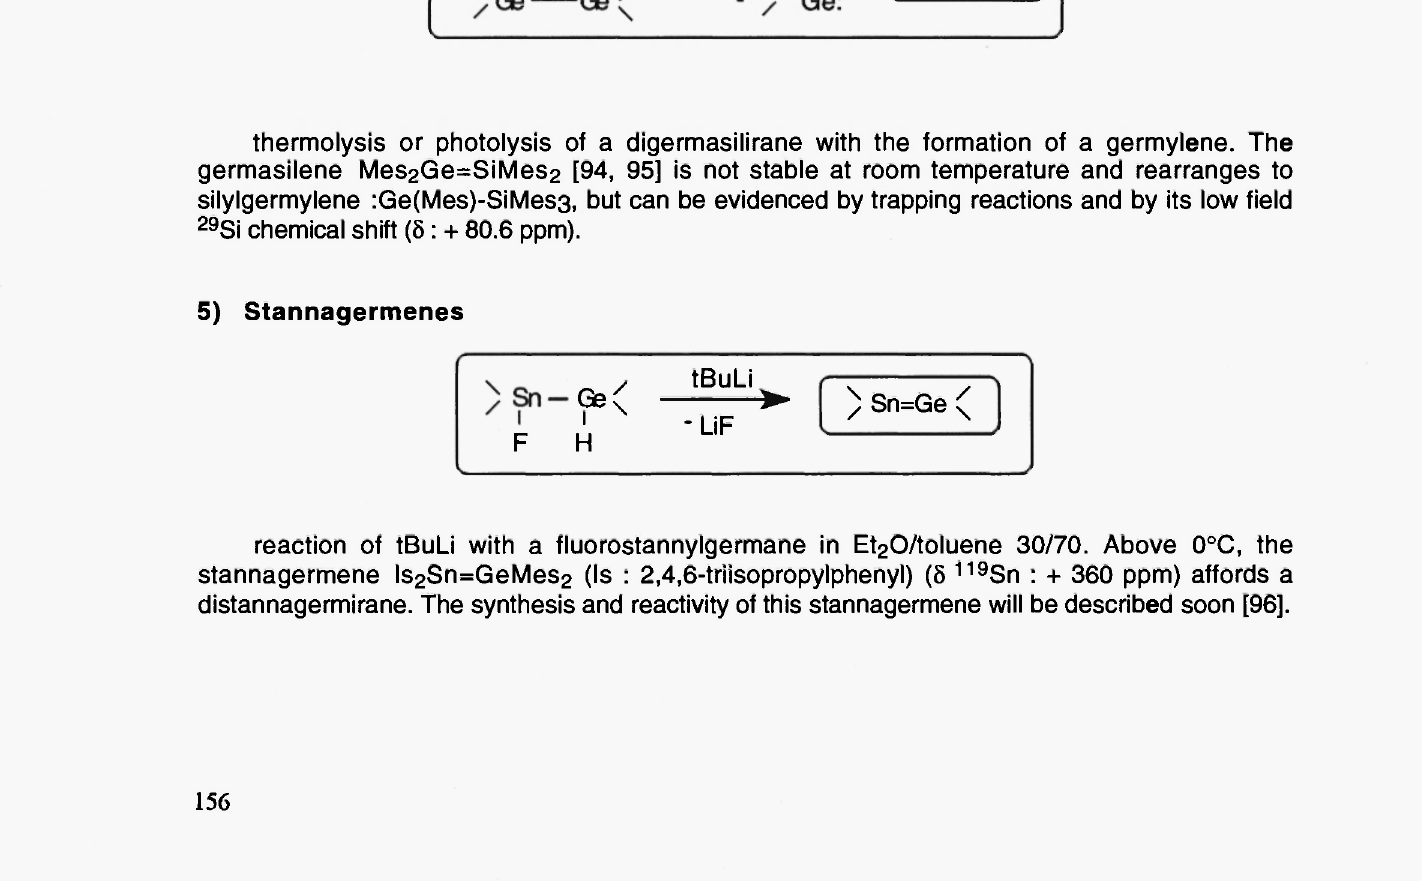
δ 119 Sn (ppm) ( 1 J S nSn,